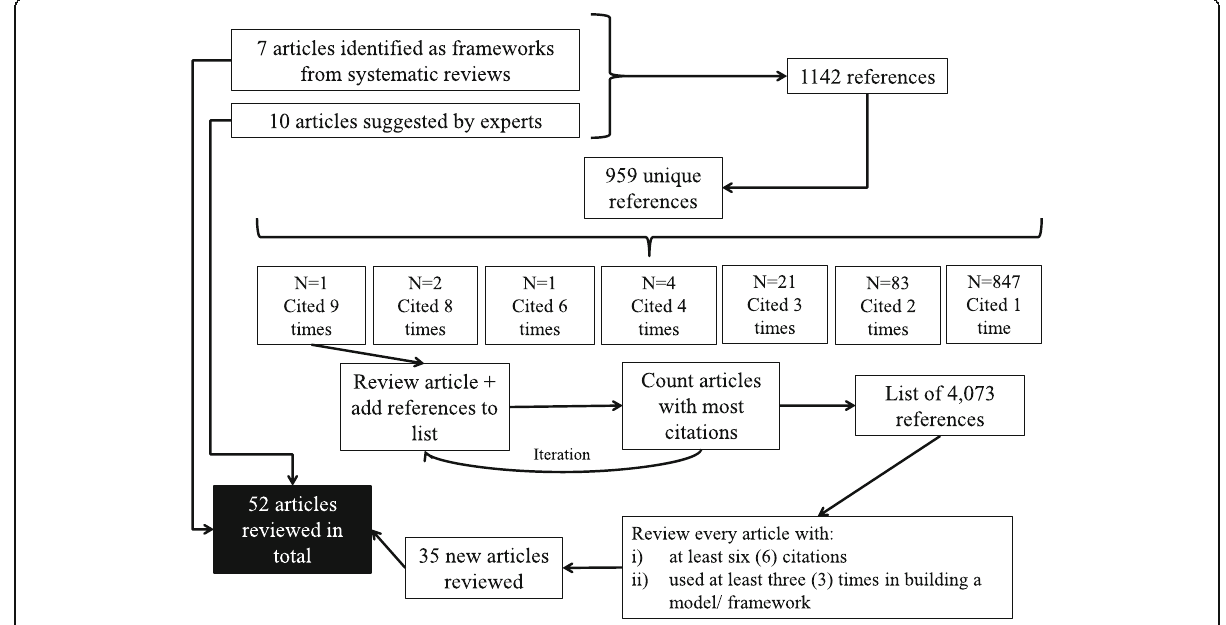
Fig. 1 Flowchart of the search and selection process. Source: Authors elaboration.